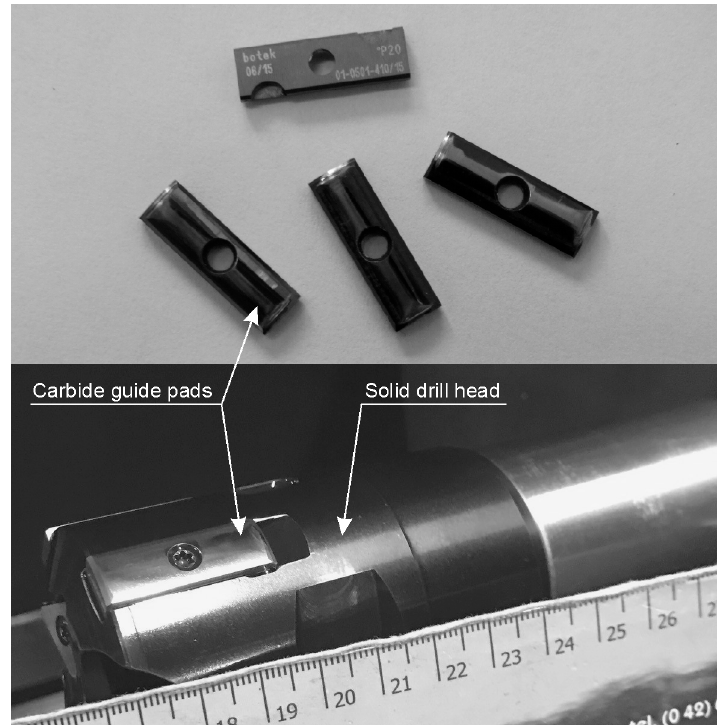
Figure 1. Carbide guide pads (upper) and solid drill head (lower).